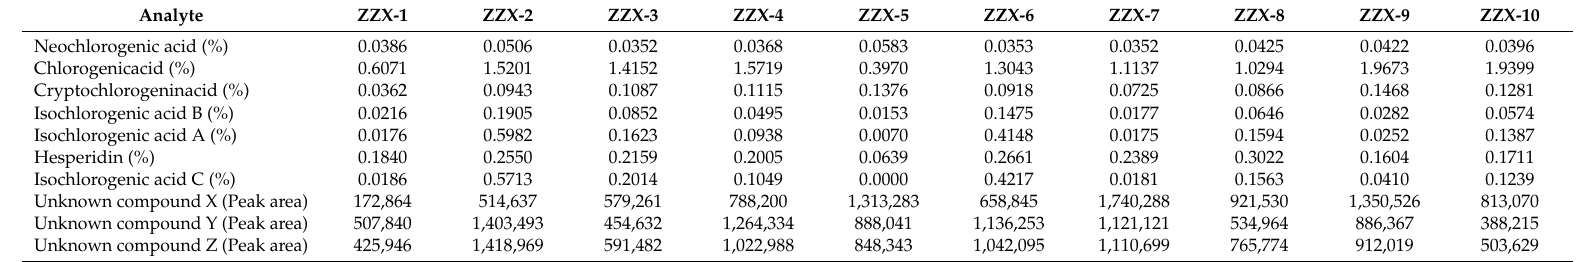
Table 3. Contents or peak area of 10 common compounds in 10 batches of ZZX